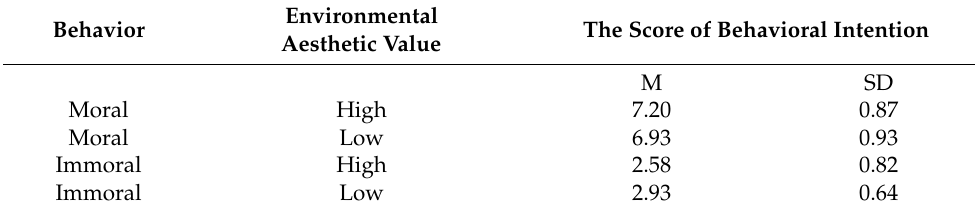
Table 2. Mean rating score of behavioral intentions in different environments (M ± SD) in Experi- ment